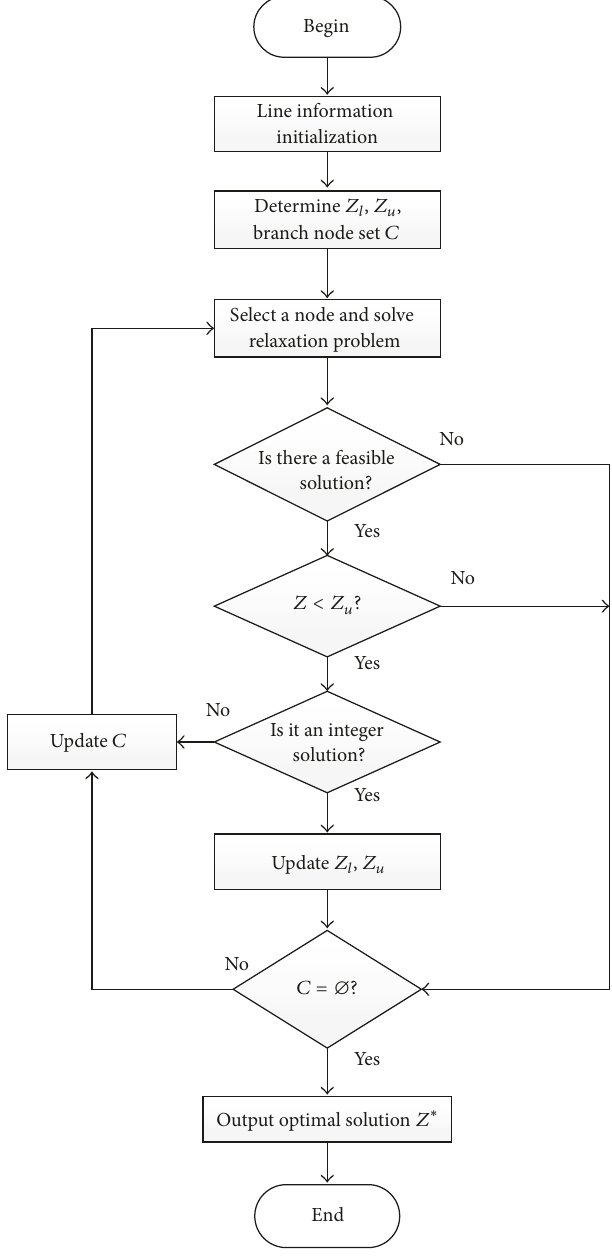
Figure 3: The flowchart of branch-and-bound